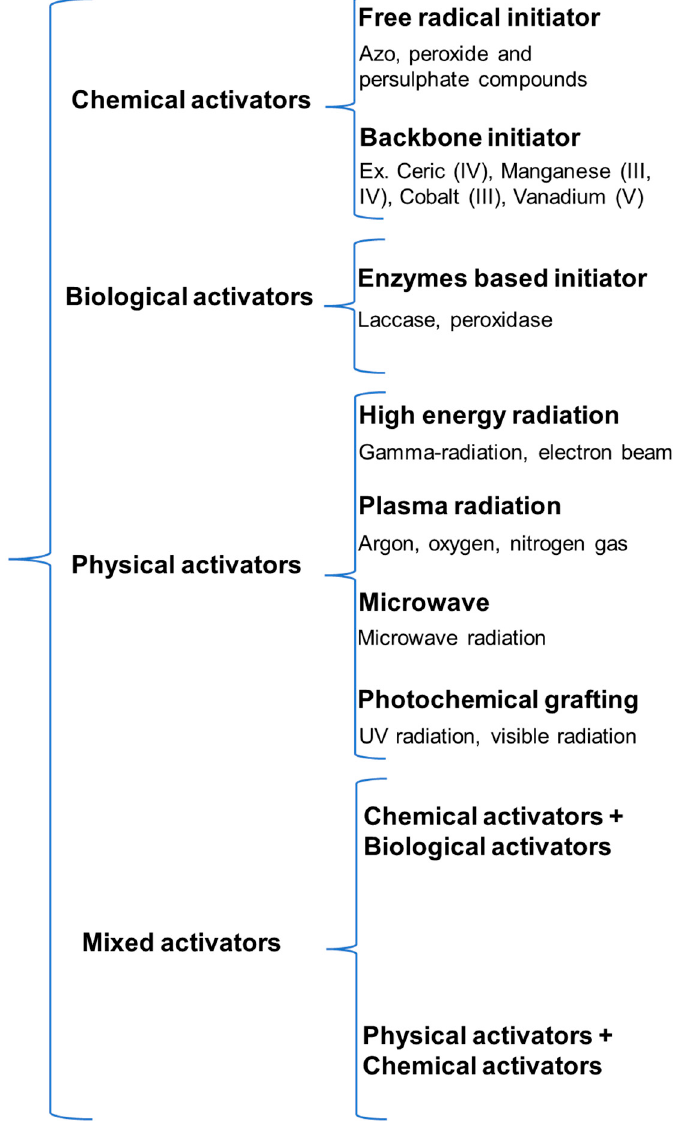
Figure 4. Activator types used for graft polymerization.